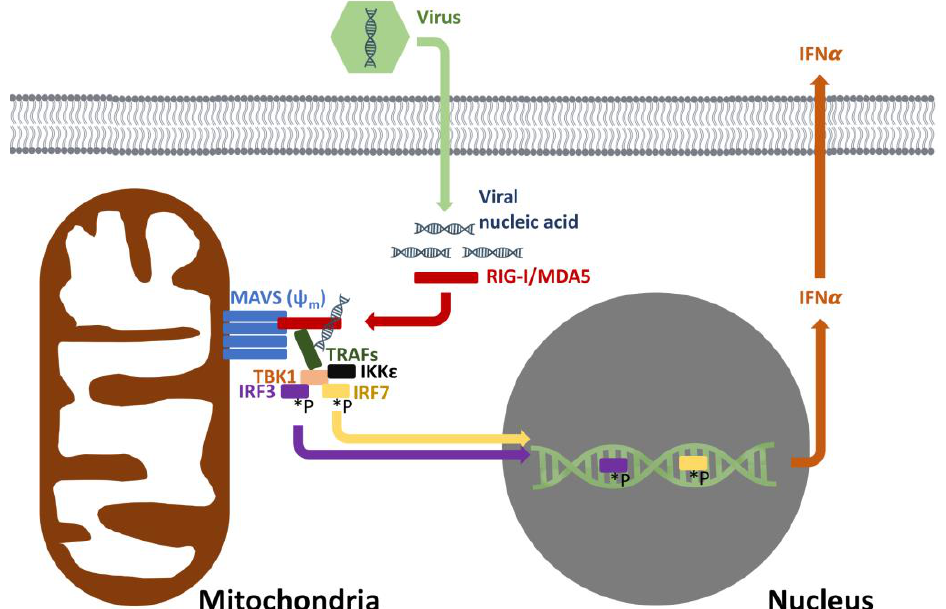
Figure 2. Mitochondrial antiviral response. The recognition of viral nucleic acids involves mitochondria and intact membrane potential ( ψ m ). RIG-I and MDA5 recognize cytoplasmic viral nucleic acids, leading to the oligomerization of MAVS. MAVS then sets in motion a signaling pathway that eventually leads to the phosphorylation (*P) of IRF3/7 with subsequent induction of IFN α to offer antiviral cellular protection. RIG-I = retinoic acid inducible gene I, MDA5 = melanoma differentiation-associated protein 5, MAVS = mitochondrial antiviral-signaling protein, TRAFs = TNF receptor associated factors, TBK1 = TANK binding kinase 1, IKK ε = inhibitor of nuclear factor kappa-B kinase subunit epsilon, IRF 3 = interferon response factor 3, IRF 7 = interferon response factor 7, INF α = interferon alpha.